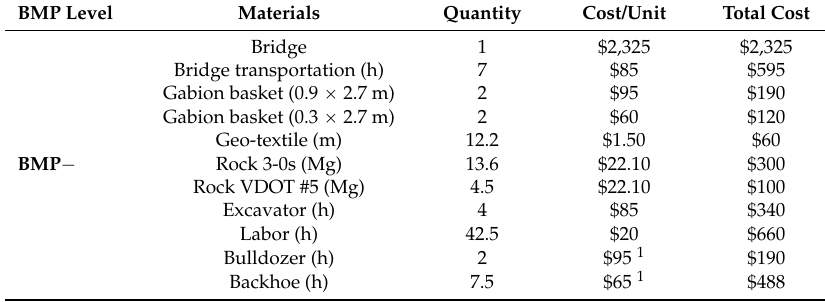
Table 3. Crossing and BMP construction materials and costs required for construction of a wood panel